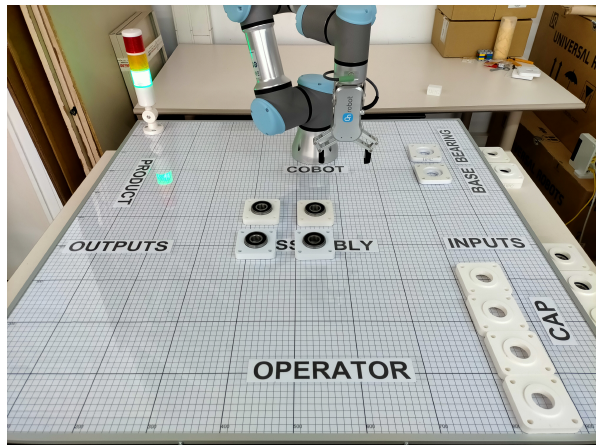
Figure 4. The collaborative assembly area implemented in the University